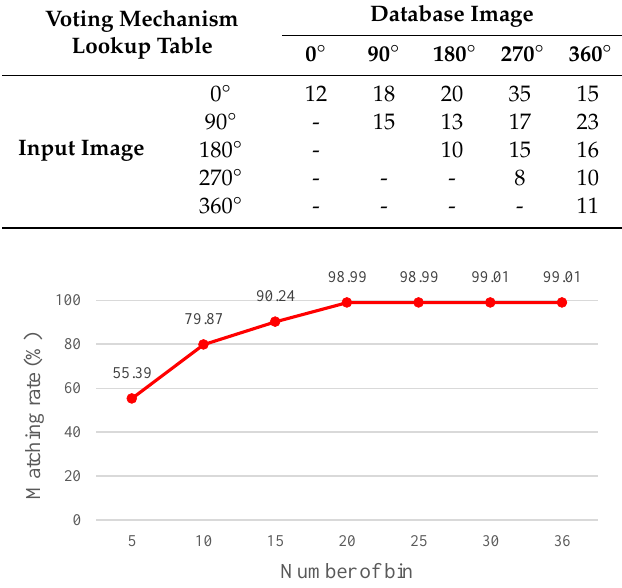
Figure 18. Computation time required for various numbers of rotations.